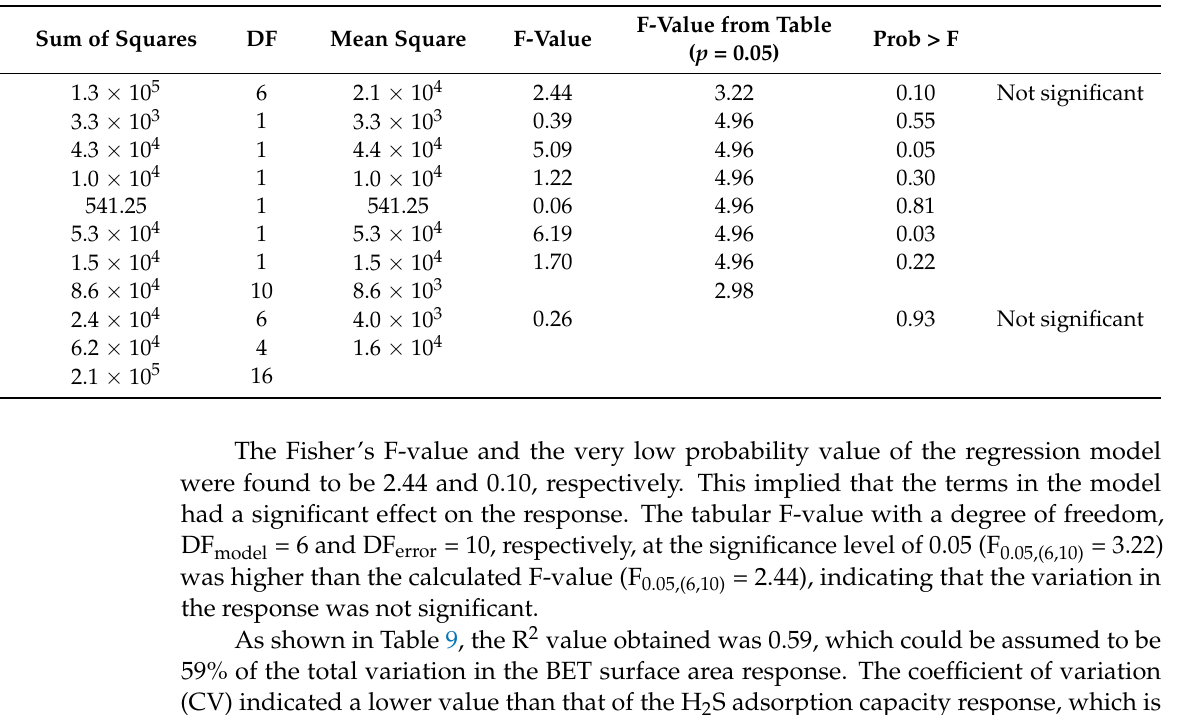
Table 8. Analysis of variance (ANOVA) of BET surface area responses.